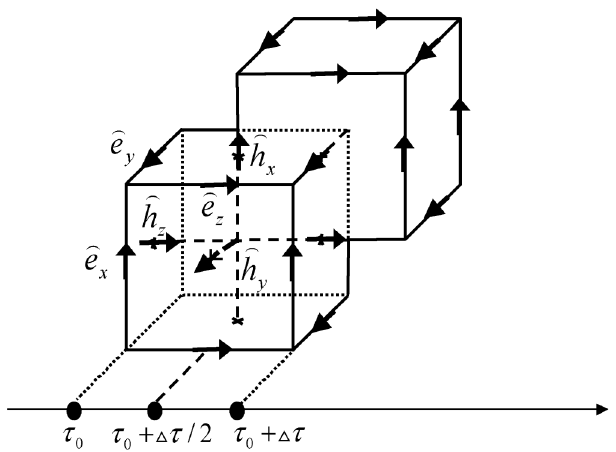
FIG. 2. Positions of the relativistic charged particle in the finite integration technique grid in different moments of time. The scaled time step is chosen equal to the longitudinal mesh